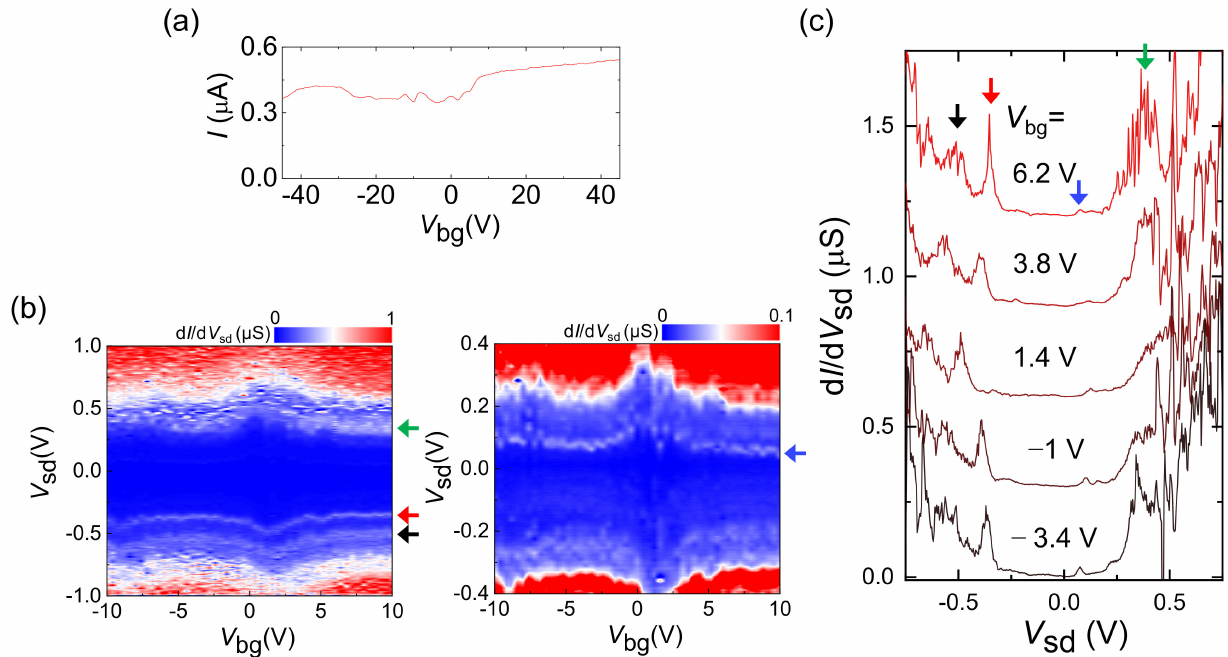
Figure 6. ( a ) Transfer curve for an m -MWCNT ( L ≈ 1 µ m, D ≈ 4.8 nm) at V sd = 1 V and T = 4.2 K. ( b ) Left panel: d I /d V sd as a function of V sd and V bg for the m -MWCNT. Right panel: Zoomed plot of the left panel with a different contrast. ( c ) d I /d V sd as a function of V sd for various V bg of the m